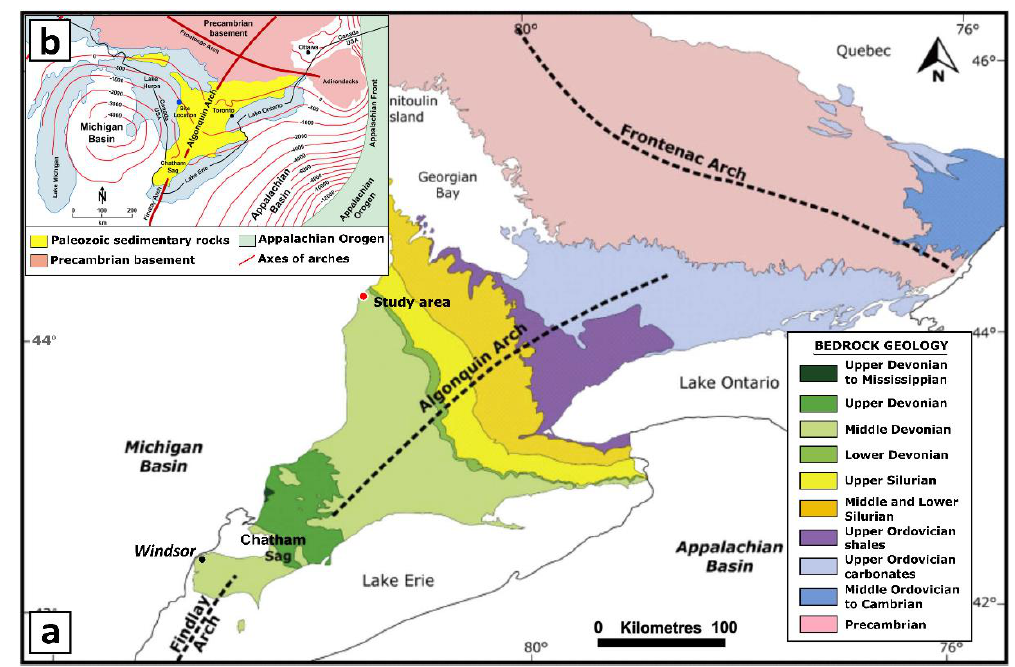
Figure 1. ( a ) Generalized Paleozoic Bedrock Geology Map of Southern Ontario (modified from OGS [16] and OPG [17]); ( b ) generalized basement structural contours (meters above the sea level datum) and location of structural arches and basins (modified from OPG [17] and Johnson et al. [18]).